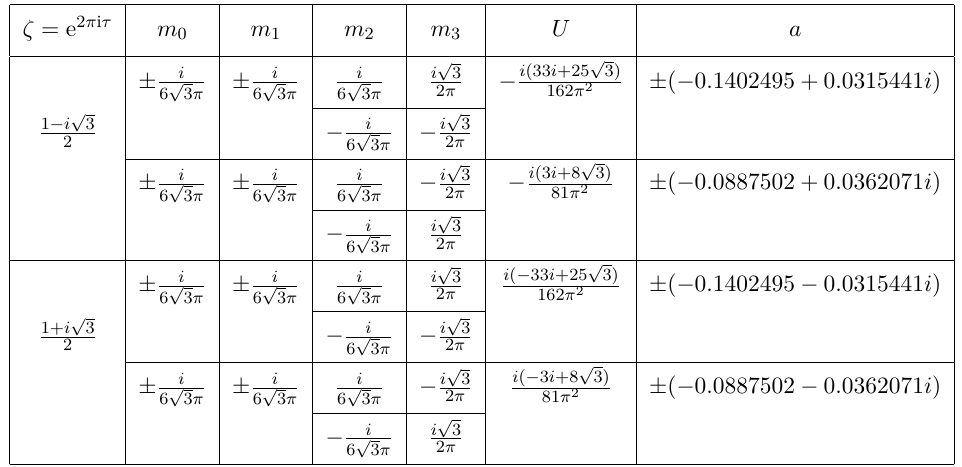
Table 7. The parameters obtained from Γ 0 (9) . Using (3.21), we can get the values for α i ’s and Q .